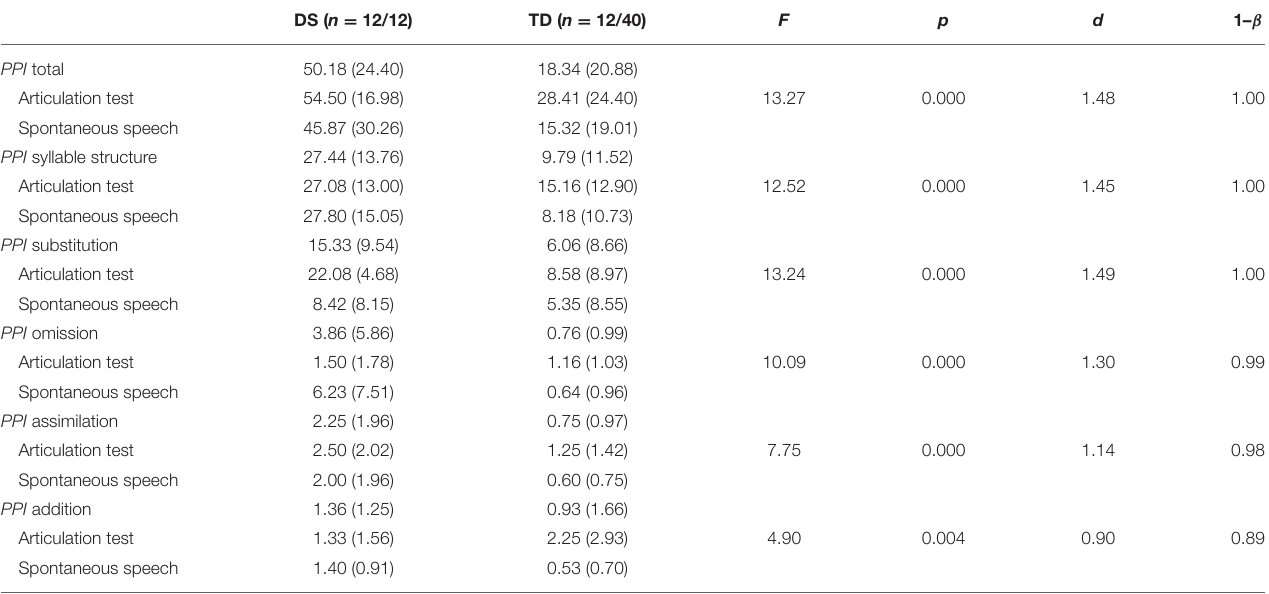
TABLE 1 | Phonological processes index (total and by classes) means and standard deviations for groups and methods, 2 × 2 ANOVA F values, effect size, and power of